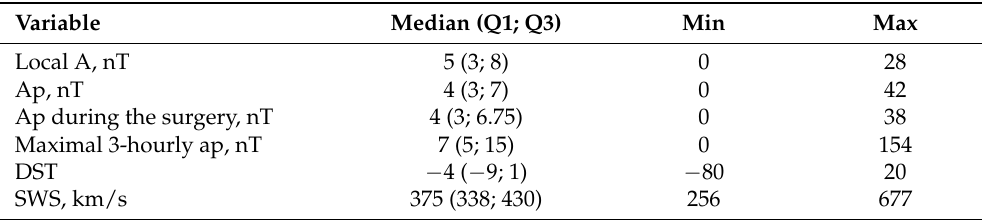
Table 1. The descriptive characteristics of geomagnetic activity indices and SWS during the days of ECG (N = 495).